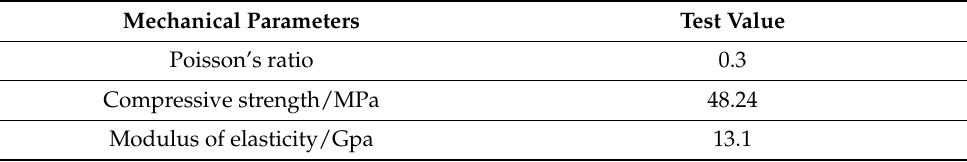
Table 1. Mechanical parameters of specimens.